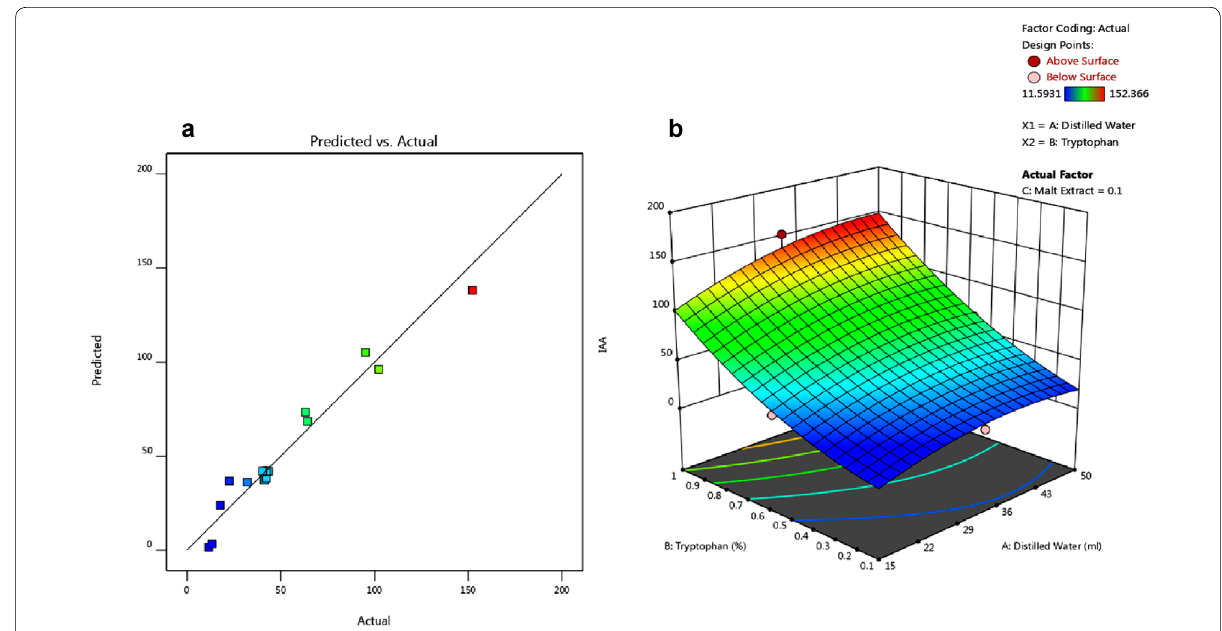
Fig. 3 Response surface plot for optimum IAA production a actual vs predicted, b 3D surface